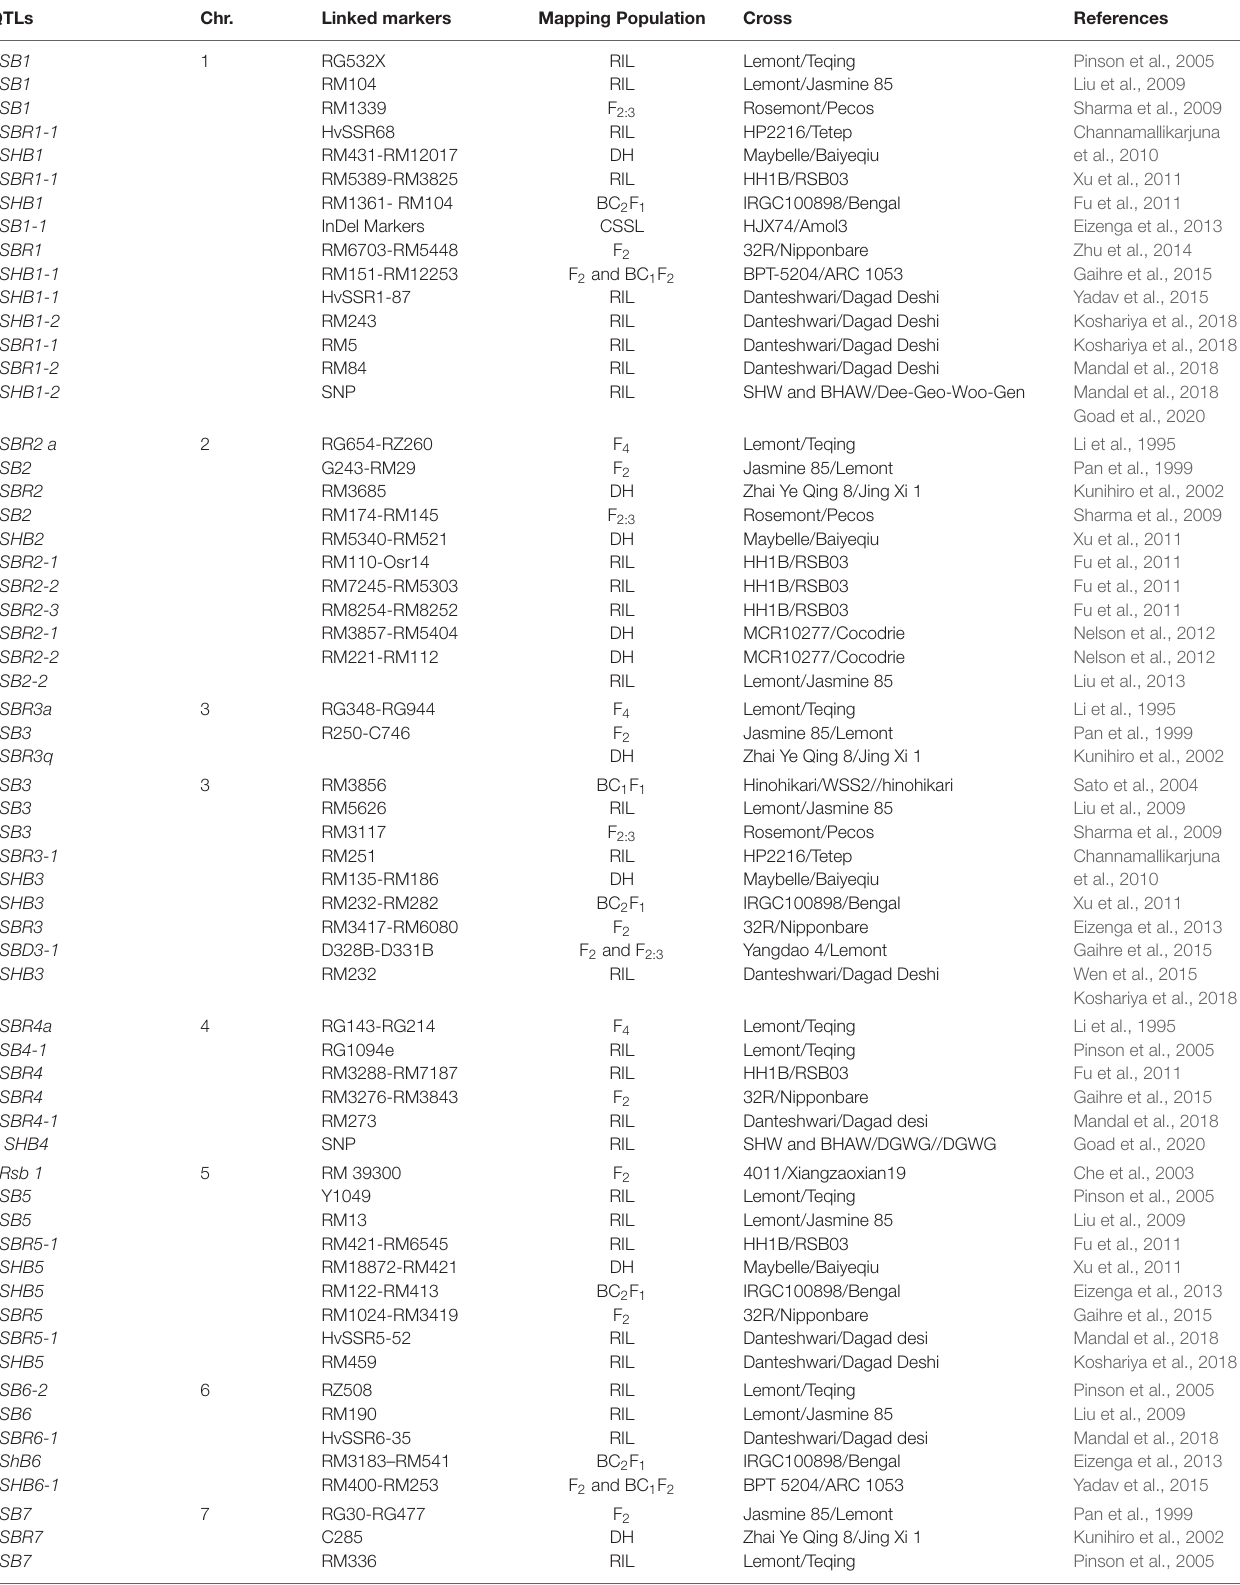
TABLE 4 | List of QTLs mapped for sheath blight resistance in rice. QTLs Chr. Linked markers Mapping Population